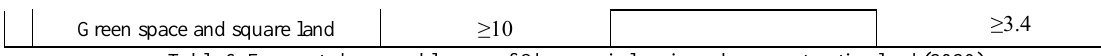
Table 6. Forecasted reasonable area of Chengmai planning urban construction land (2020)